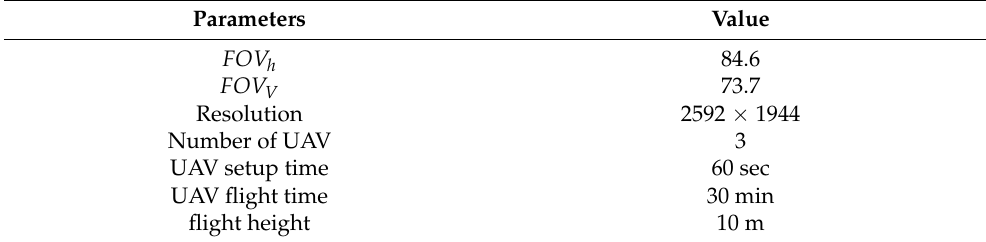
Table 1. Simulation Parameters.